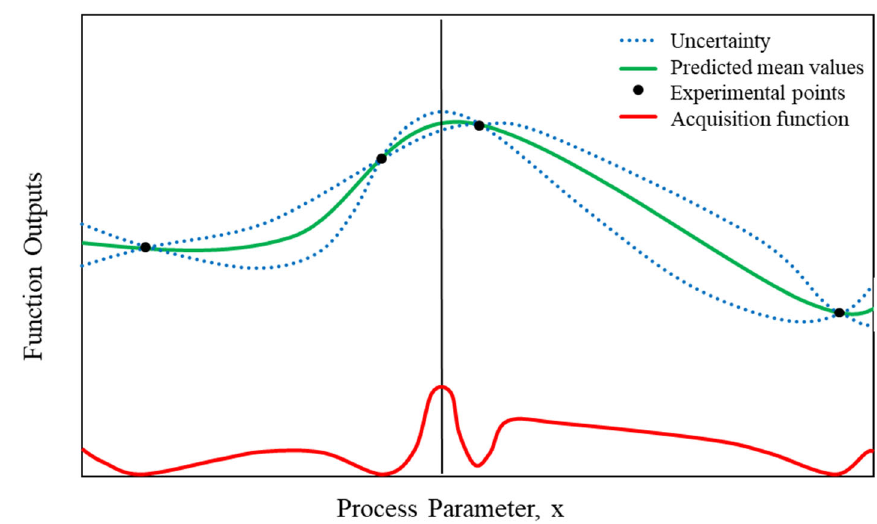
Figure 3. Conceptual representation of a one ‐ dimensional Gaussian process, where several points are defined due to experimental testing of the relevant process. The blue and green lines represent the uncertainty and predicted mean values of the objective function, respectively. The red line represents the acquisition function, and the vertical black line denotes the next requested experimental point.